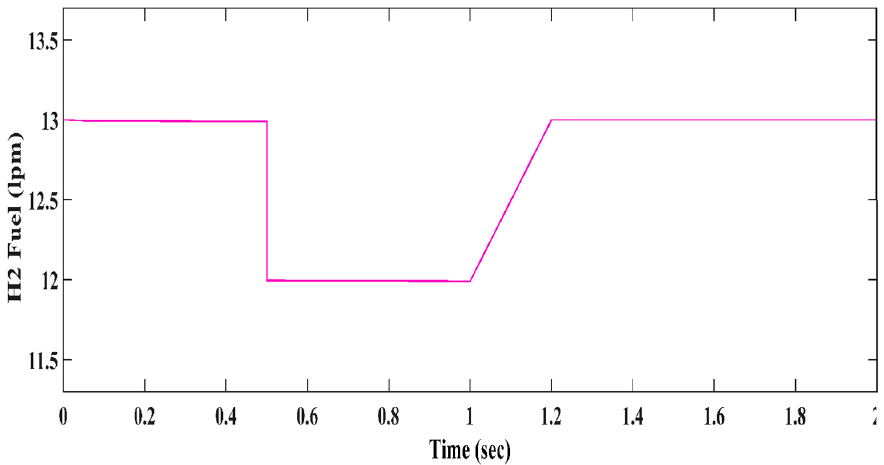
Figure 18. Hydrogen (fuel) input pattern for FC framework.